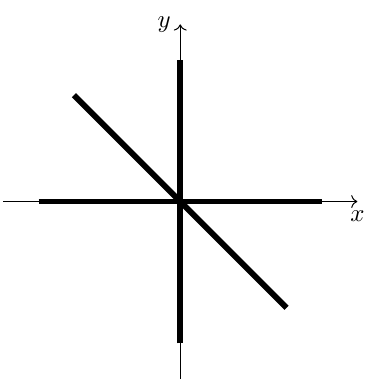
Figure 1 . Hyperplane arrangement for C ( S ) = U ( Gr 2 ( C 3 )). The axes correspond to the compo- nents of the real moment map of the residual T 2